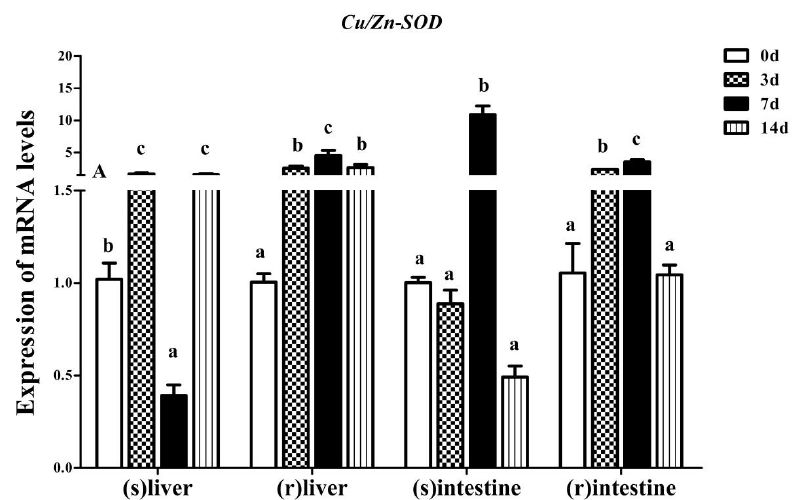
Figure 8. Relative expression of AdCu/Zn-SOD in the liver of Yangtze sturgeon during fasting and refeeding, s: starvation, r: refeeding. Data represent means ± SEM of six replicates. The different lowercase letters represent significant differences ( p < 0.05).